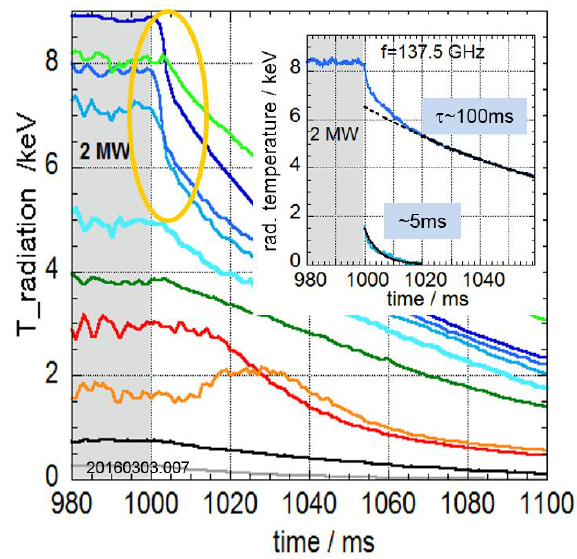
Fig. 7: Time traces from the ECE Low-Field Side right after 2 MW ECRH in a stationary low density plasma ( n e = 1.5 10 19 m -3 ) has been terminated. The inlay shows exponential fits to the two timescales for a selected central LFS channel. Note that the High Field Side channel ( f= 141.1 GHz) plotted in light green displays the energy confinement time only.